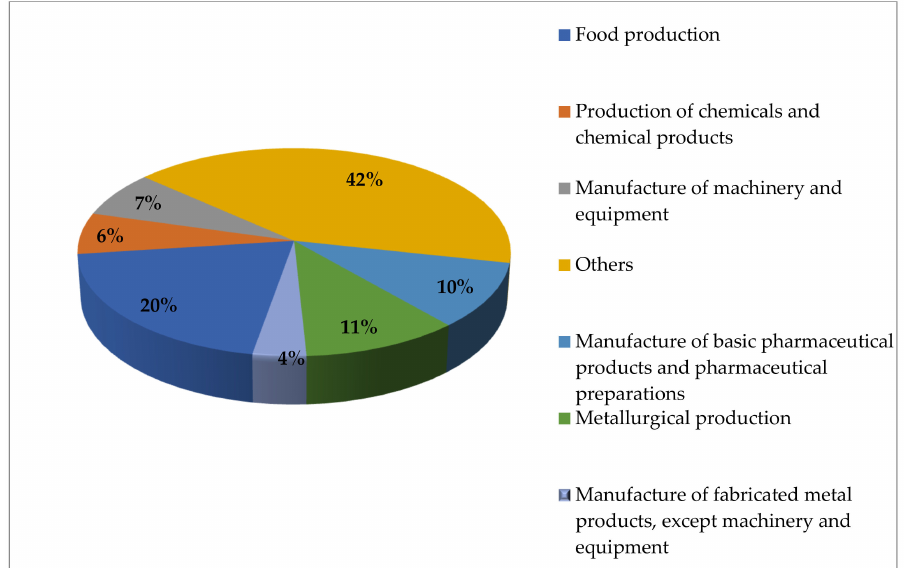
Figure 6. Structure of total costs by area of innovation, %